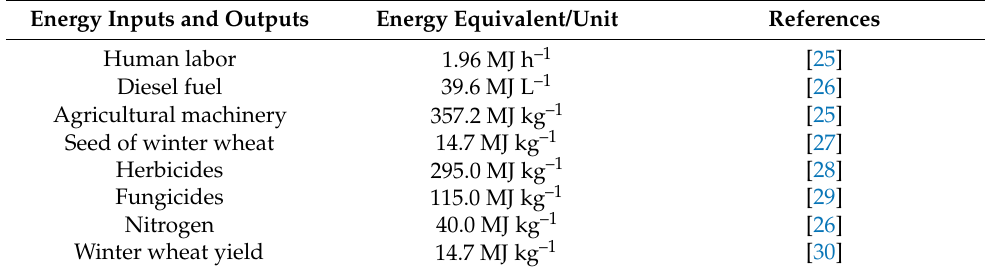
Table 2. Values of energy equivalents for different agricultural components.